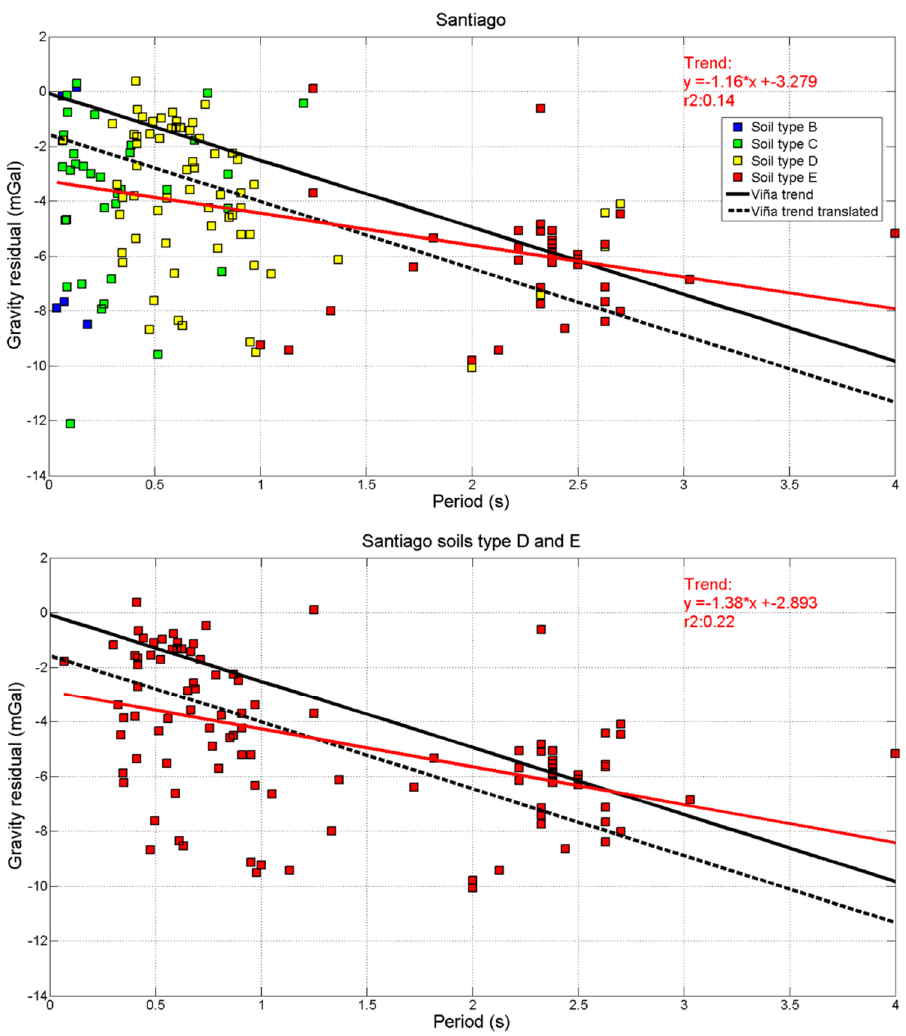
Figure 9. Correlation between gravity residuals and H/V predominant periods in Santiago. Red line corresponds to the calculated linear regression. The black lines correspond to the trend calculated for Viña del Mar. The continuous line is the original trend, while the dashed lines is displaced in − 3.5 mGal. Upper panel shows the results for all the type of sites presented in the area according to the seismic classification in Table 1. The lower panel shows the same results only for soft sites with classification of D and E.